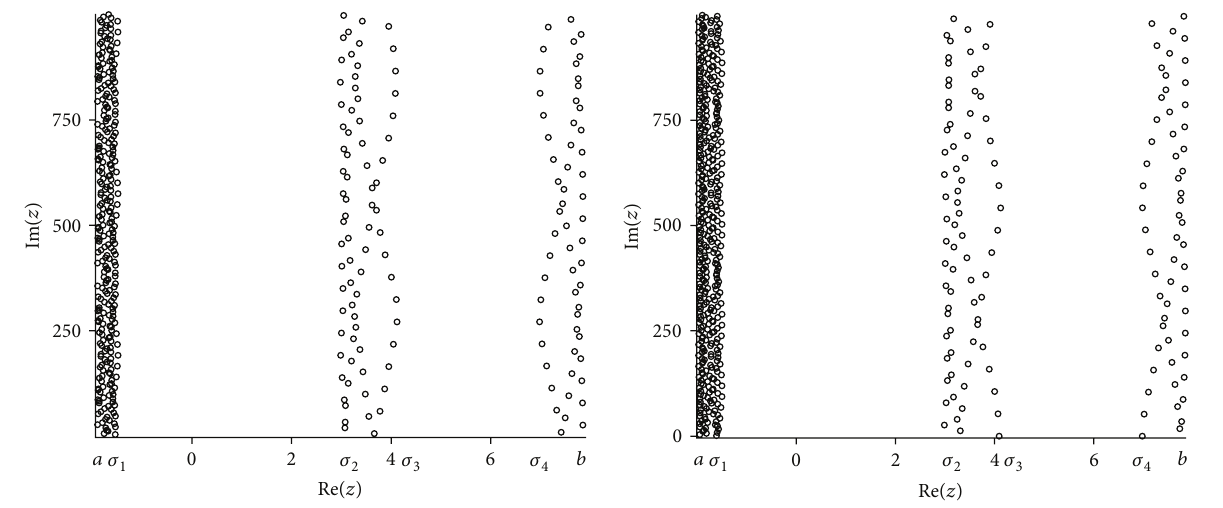
Figure 1: Zeros of the functions 𝑃 𝐴 (𝑧) and 𝑃 𝐵 (𝑧) of Example